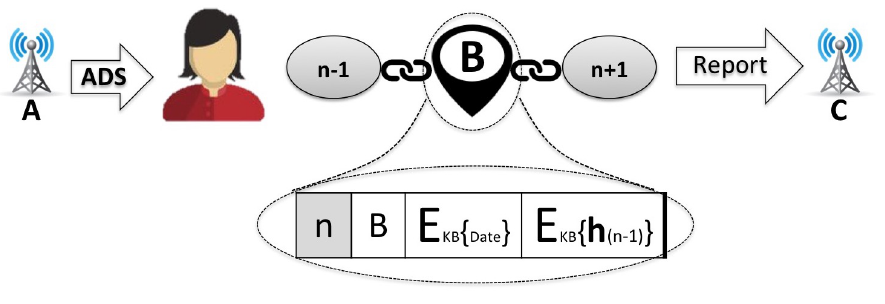
Figure 7. Behavioural verification by